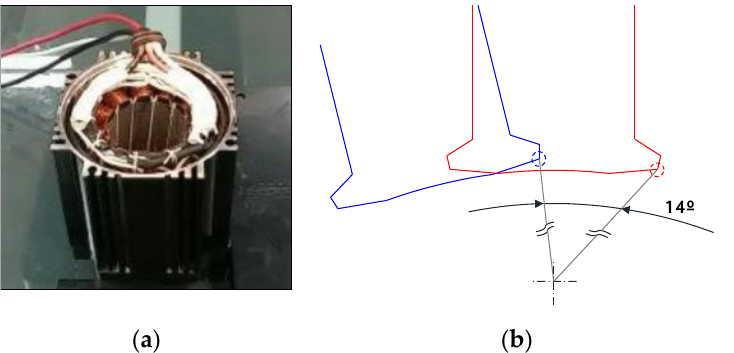
Figure 10. Measurement of the continuous skew angle for the stator-skew prototype: ( a ) stator-skew prototype; ( b ) measured skew angle.